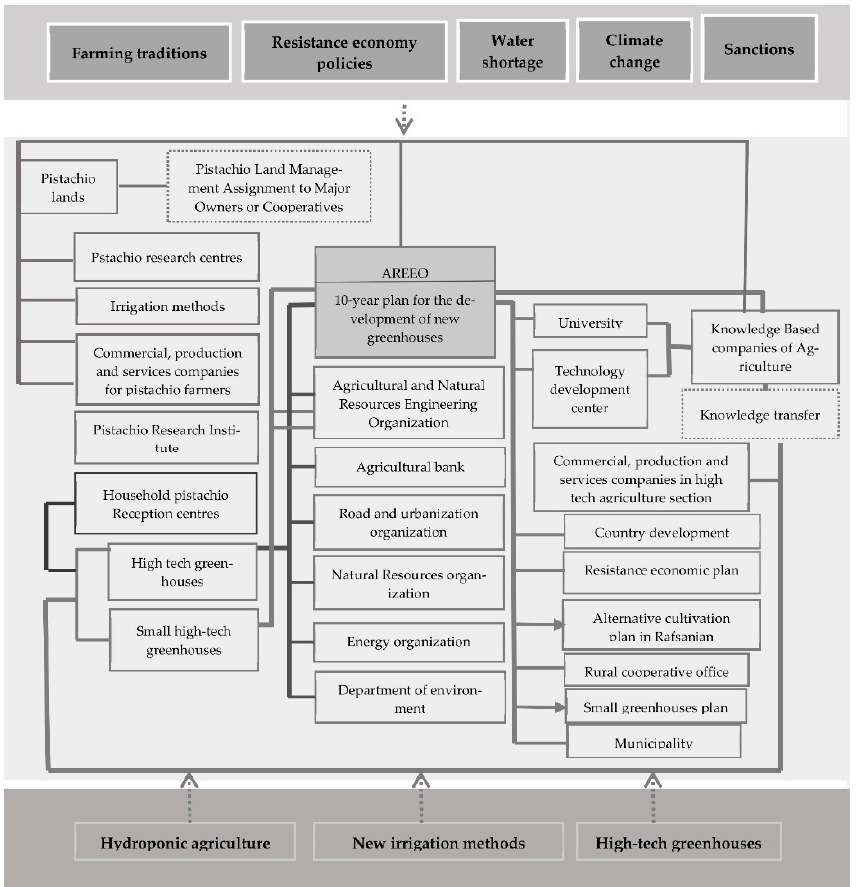
Figure 10. Illustration of the actor network of transition to high-tech agriculture.